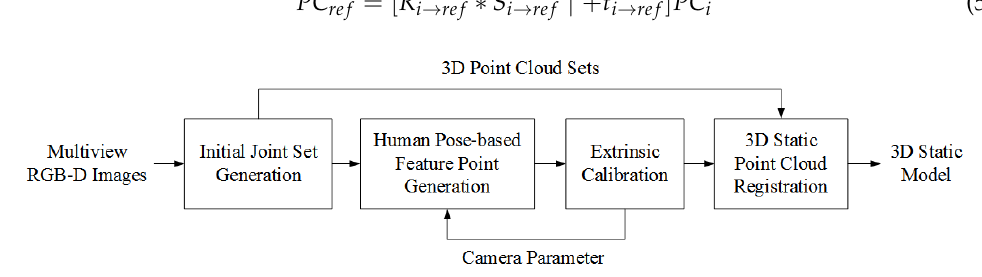
Figure 6. The proposed algorithm for 3D static registration.